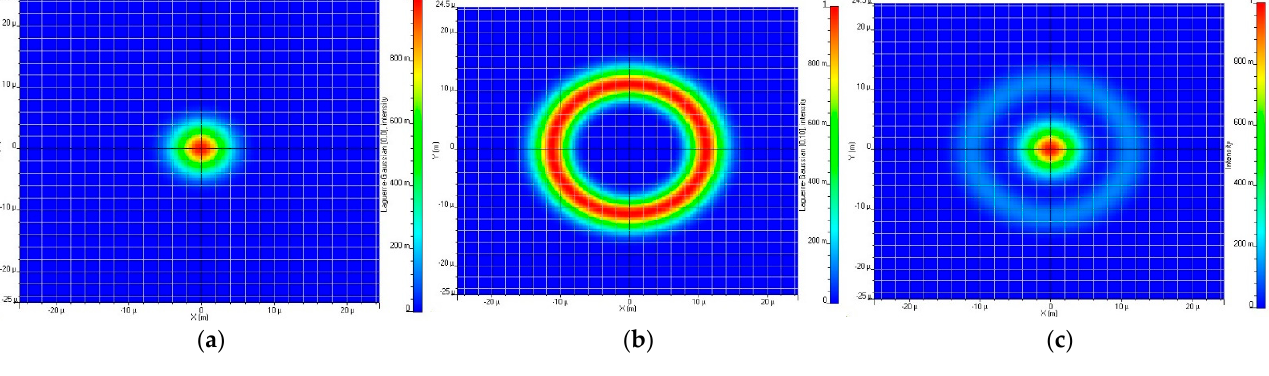
0,0 ; ( b ) LG 0,10 ; ( c ) multiplexed